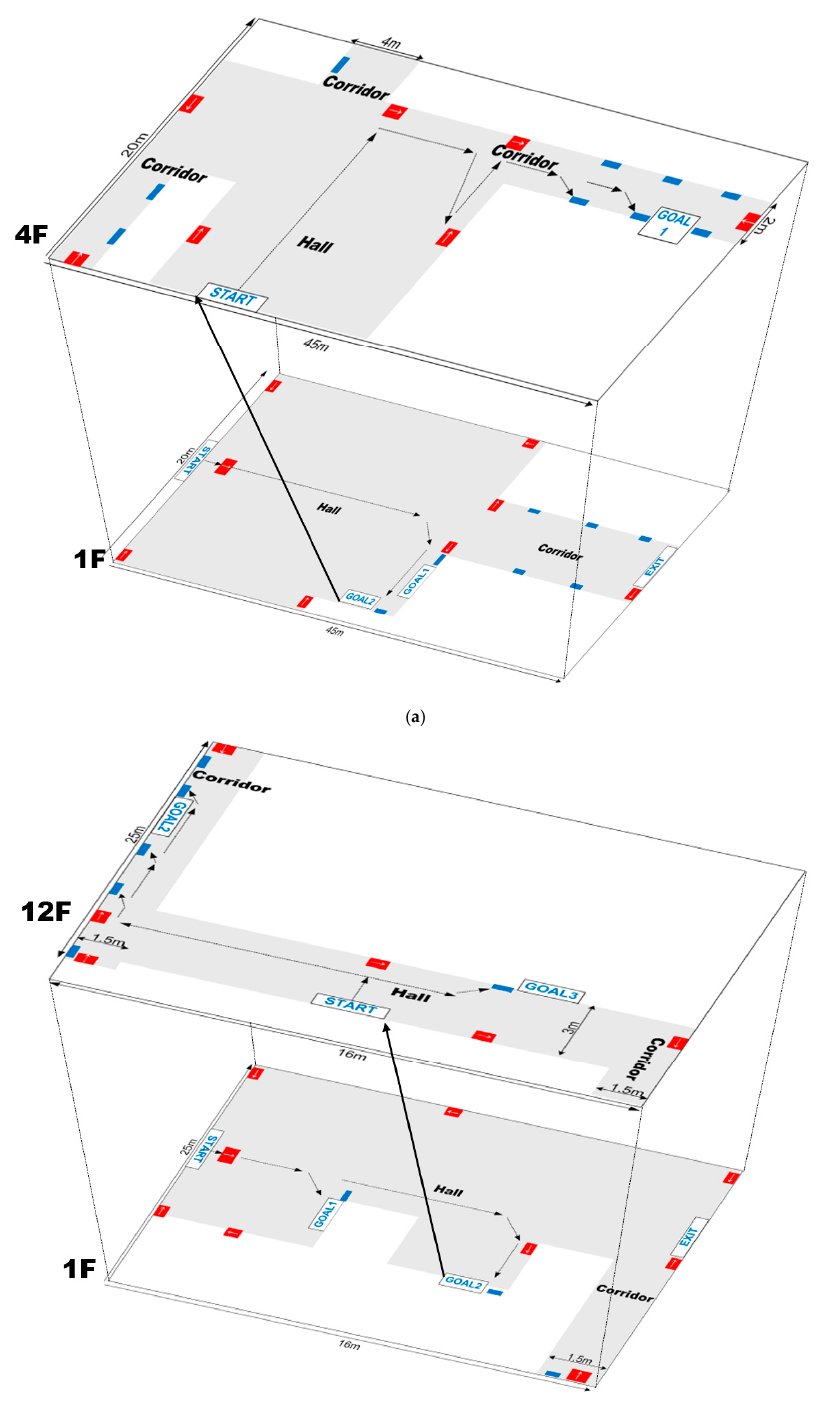
Figure 17. Test maps constructed for real environments: ( a ) Environmental engineering building; ( b ) New millennium building.